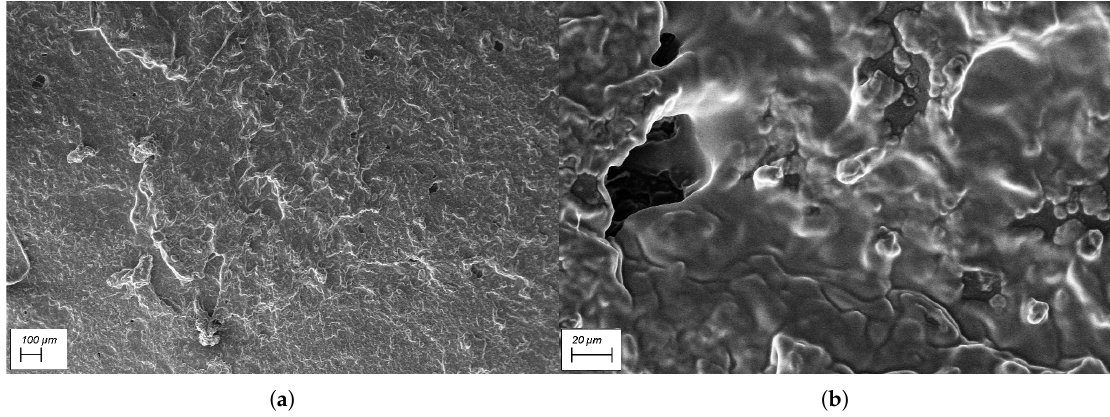
Figure 16. Microscopic images obtained using SEM: ( a ) at 100 × magnification; ( b ) at 1000 × magnification.